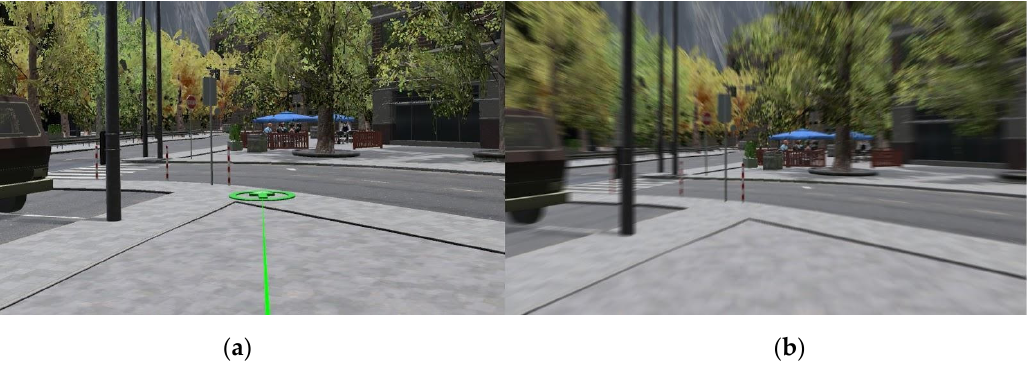
Figure 1. Environment navigation via teleport ( a ) and navigation via natural locomotion movement ( b ).